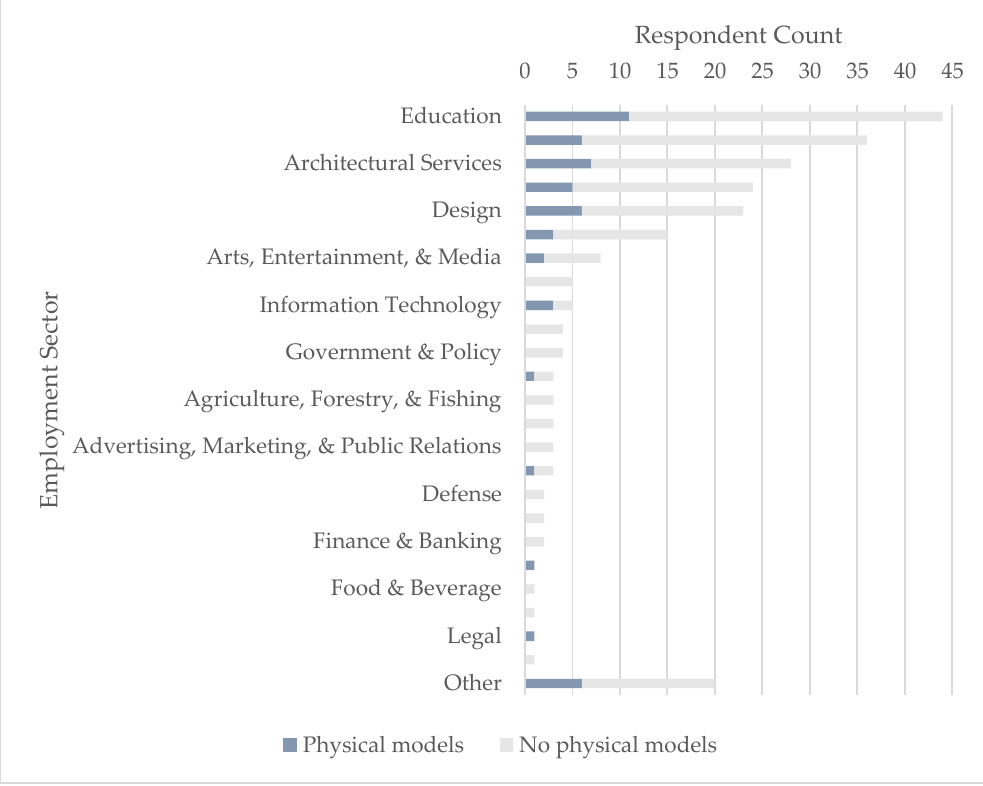
Figure 7. Use of physical models among survey respondents by employment sector.